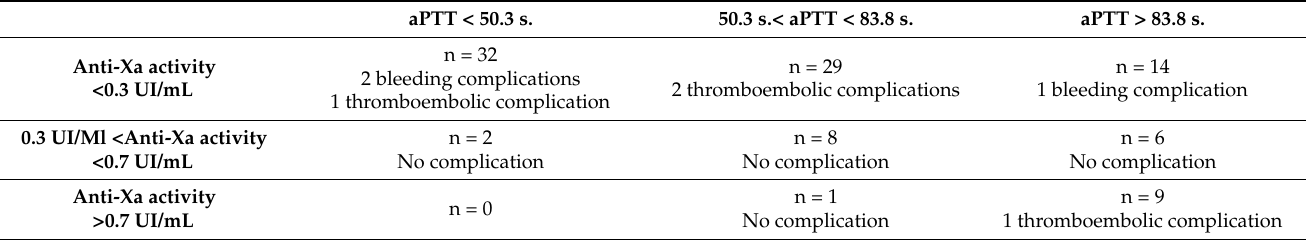
Table 2. Bleeding and thromboembolic complications according to anticoagulation target. Results are presented as absolute values; aPTT, activated partial thromboplastin time ratio. aPTT < 50.3 s. 50.3 s.< aPTT < 83.8 s.